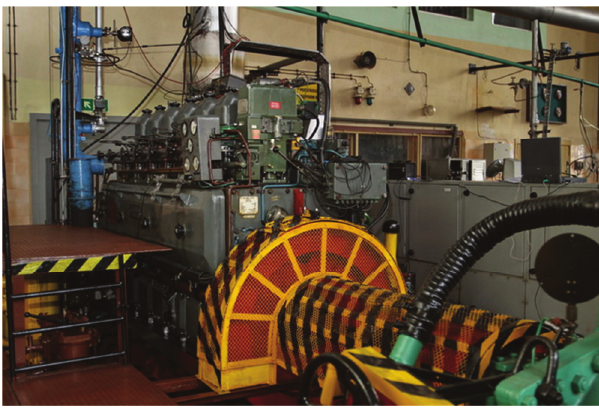
Fig. 2. Laboratory engine SULZER 6AL20/24 [8]